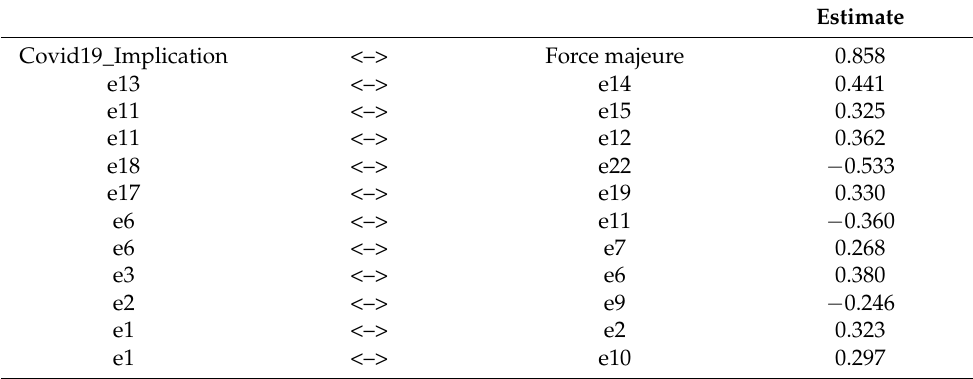
Table A3. Showing correlations in the modified